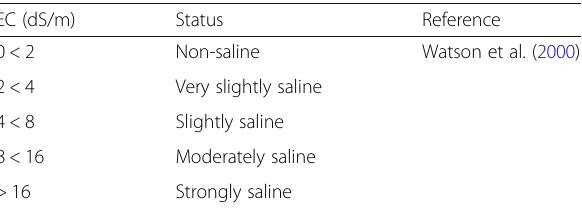
Table 2 Classes of salinity and EC (1 dS/m = 1 mmhos/cm; adapted from NRCS Soil Survey Handbook)